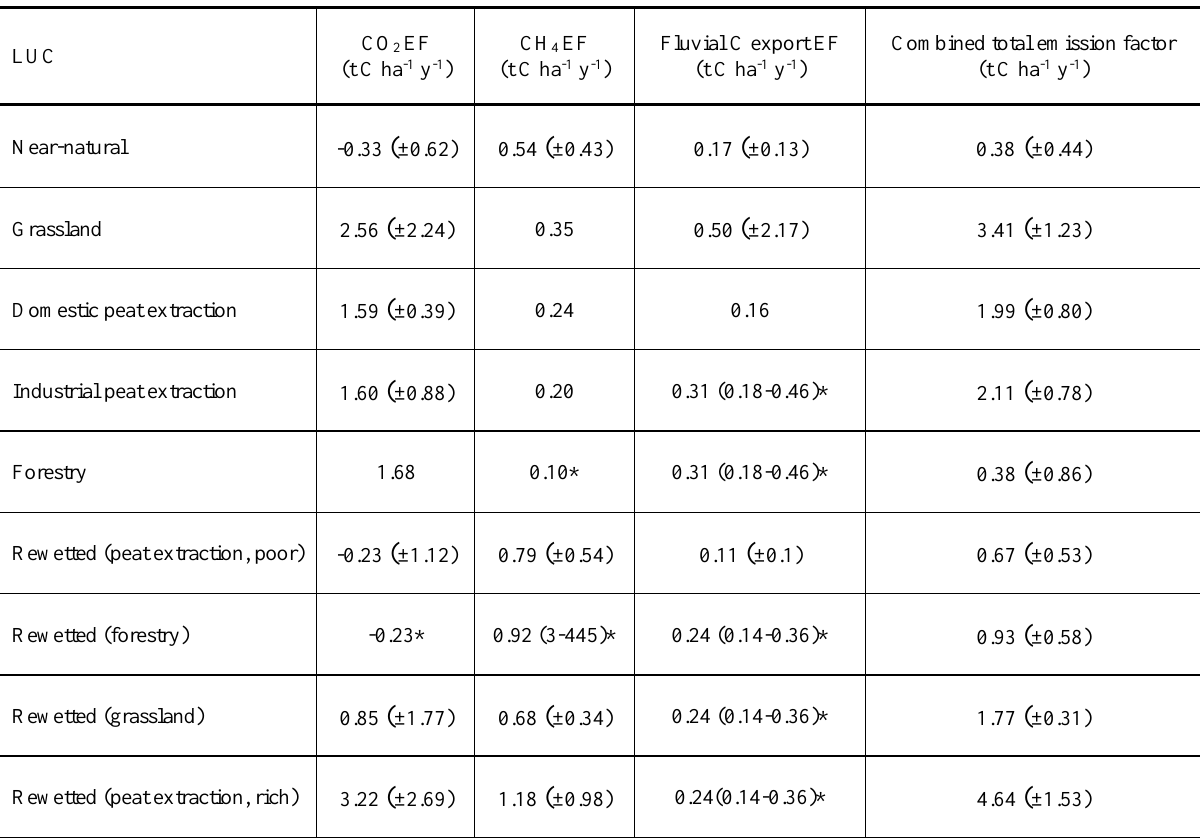
Table A1. Combined total carbon emission factor variables (t C ha -1 y -1 ) with 95 % confidence intervals in brackets for general categories of peatlands LUC presented in Table 4. The CH CH and is calculated by using Equation 2.6 in IPCC (2014). Grassland CO 4_ditch drained forestry combined EF includes trees biomass and litter sink (Duffy et al. 2021). Default Tier 1 EF values represented by * and are taken from Tables 2.2, 2.3, 2.4, 3.2 and 3.3 in the 2013 IPCC Wetlands